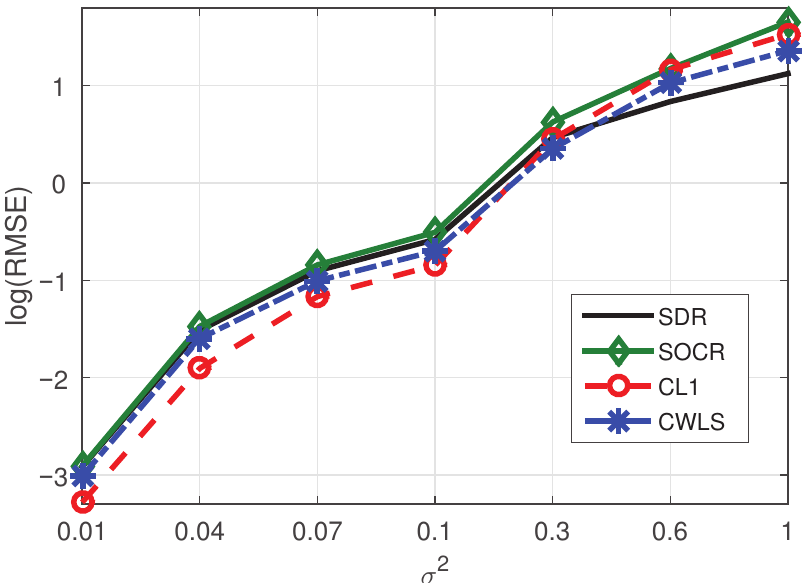
Figure 6. RMSE comparison of four methods under the conditions of eight BSs and two NLOS.